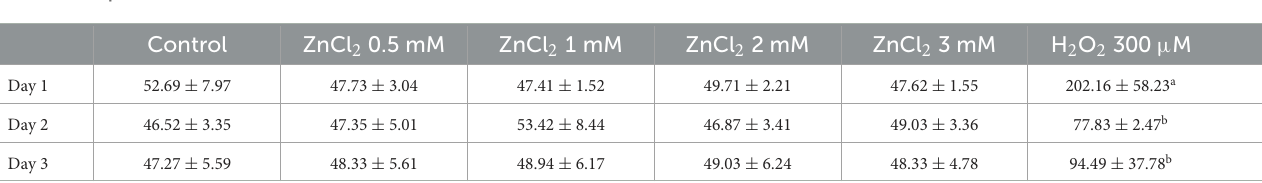
TABLE 3 ROS production.